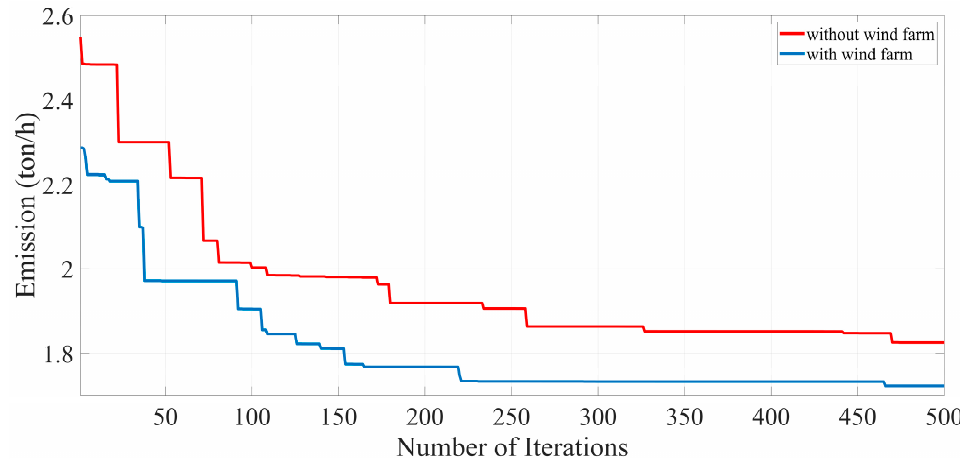
Figure 9. The convergence curves for the minimization of power losses across the transmission lines for the Test System 2.